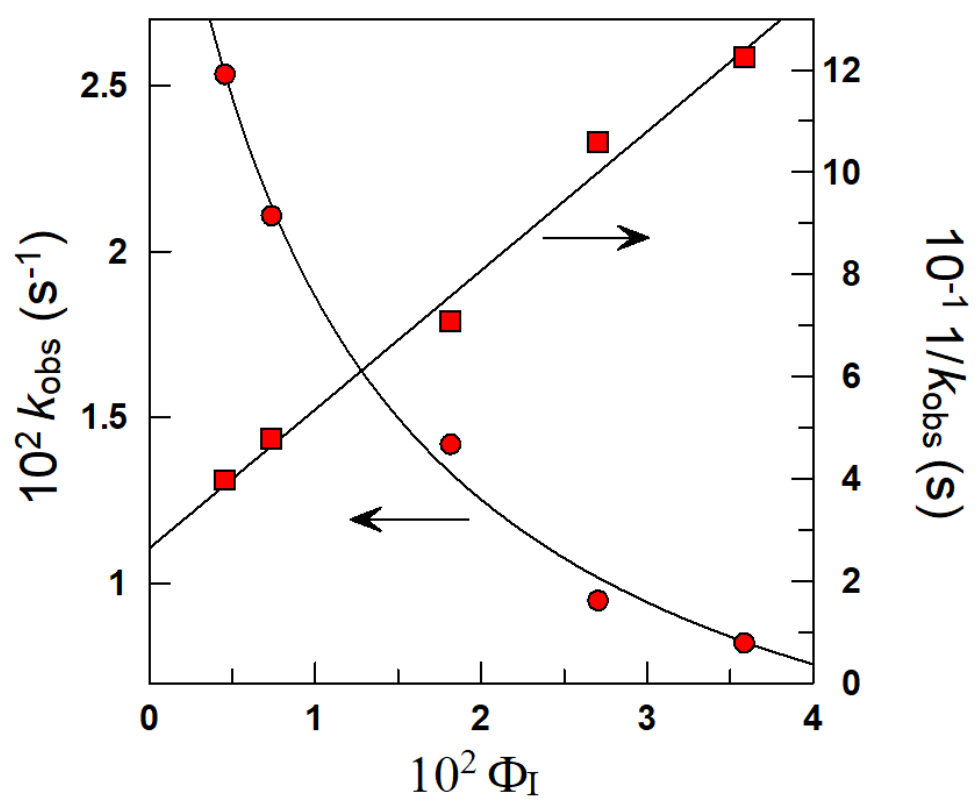
Figure 4. Variation of the observed rate constants with the emulsifier volume fraction ( Φ I ) for the reaction between chemical probe and GA in 1:9 (O/W) nanoemulsions. pH = 3.65 (citric-acid-citrate